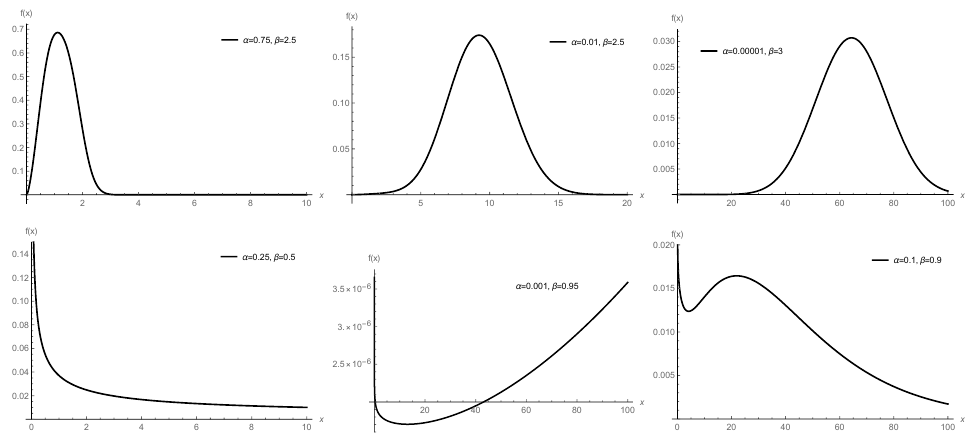
Figure 1. Different plots of the PDF of the PHD using different values of parameters. Reliability Functions The survival function ( S r F ) and hazard rate function ( H r F ) of the PHD are defined,